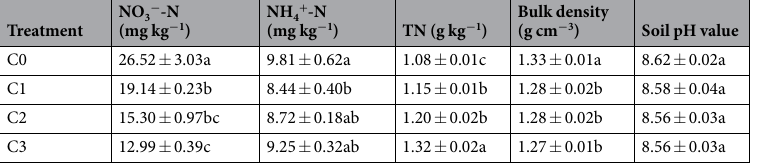
Table 1. Soil inorganic N, soil TN, bulk density and soil pH value under the four experimental treatments. Data are mean ± SE. Lowercase letter in the same column represents significant differences among experimental treatments at the level of